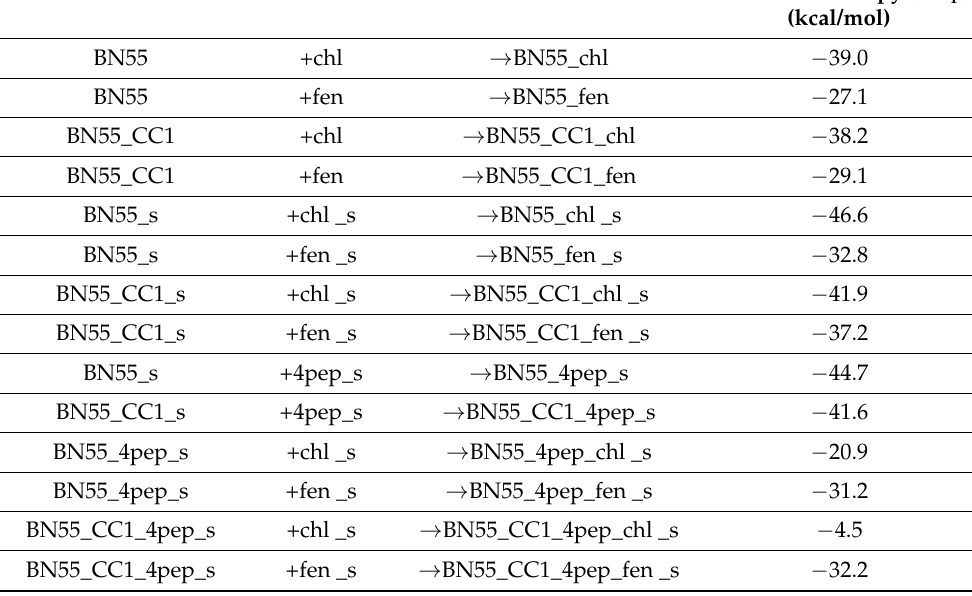
Table 1. Reaction enthalpy ( ∆ H f in kcal/mol) of chlorpyrifos (chl) and fenitrothion (fen) adsorbed on carbon-doped armchair (5,5) boron nitride nanotube (BN55-CC1) without and decorated with tetrapeptide